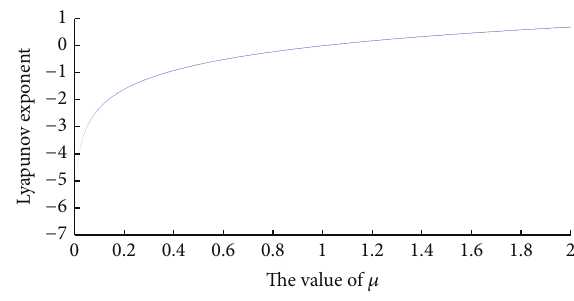
Figure 1: Lyapunov exponent spectrum of Tent